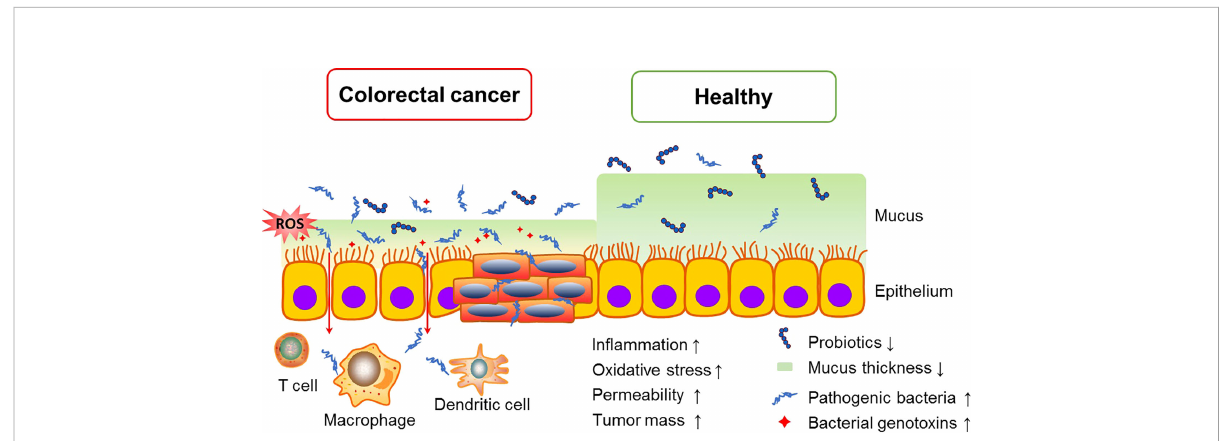
FIGURE 2 Intestinal dysbiosis accelerate CRC tumorigenesis. Overgrowth of pathogenic bacteria produce toxic metabolites, which can interfere with the cell cycle regulation and directly damage DNA, and also induce chronic in fl ammation and oxidative stress, consequently promoting CRC growth and